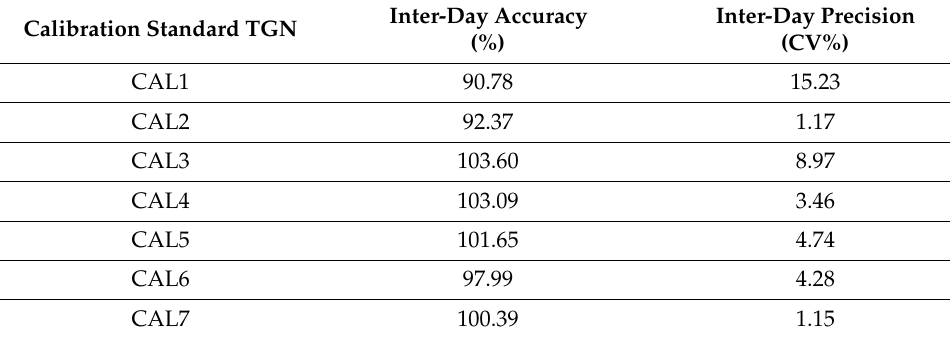
Table 4. Inter-day accuracy and precision (CV%) referred to CALs of TGN.